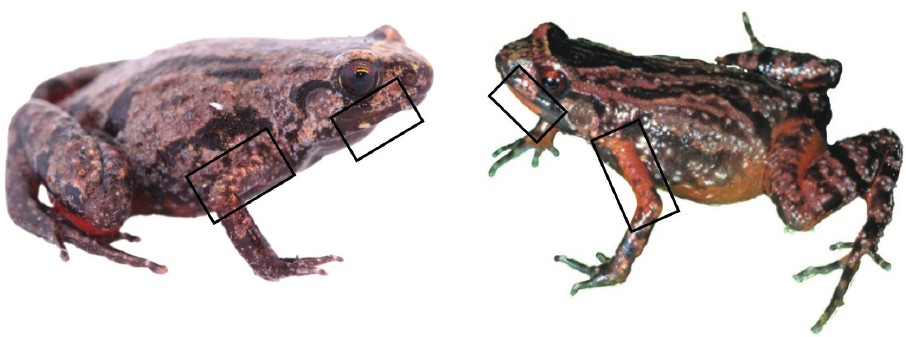
Figure 6. Direct comparison between the holotype of S. lynnae ZSM 1/2022 (KAMU2) and a female S. kibomena specimen from An’ala (photo Frank Glaw). Boxes highlight the morphological differences highlighted; elongated red marking on each side of the lower jaw on S. kibomena , absent on the observed S. lynnae , and the red arms on S. kibomena compared to the brown arms on S. lynnae